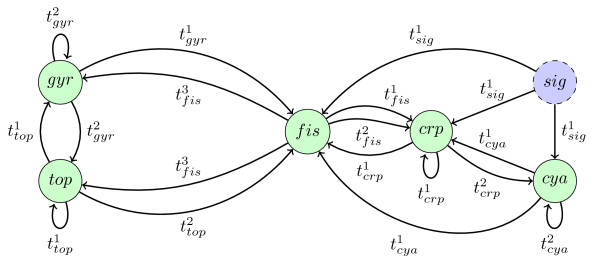
Interaction graph  for the model about carbon nutritional stress in E. coli.